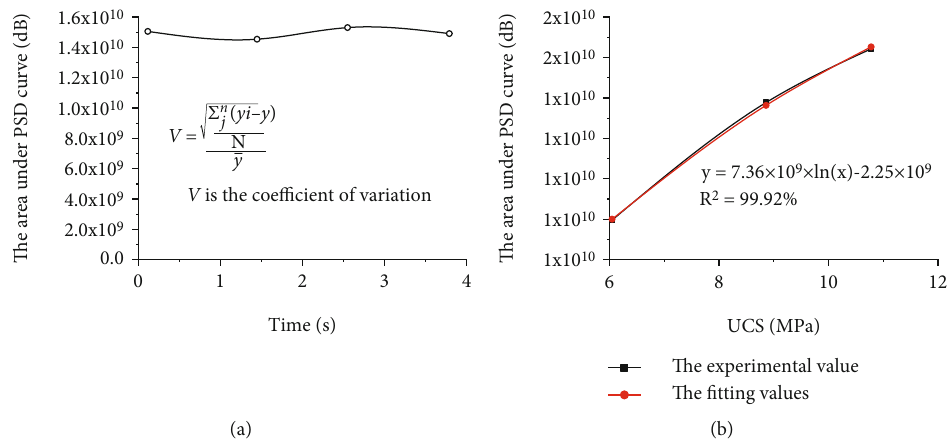
Figure 8: PSD curve integral area characteristic curve: (a) area under PSD curve at Peak Force; (b) area under PSD curve three kinds of